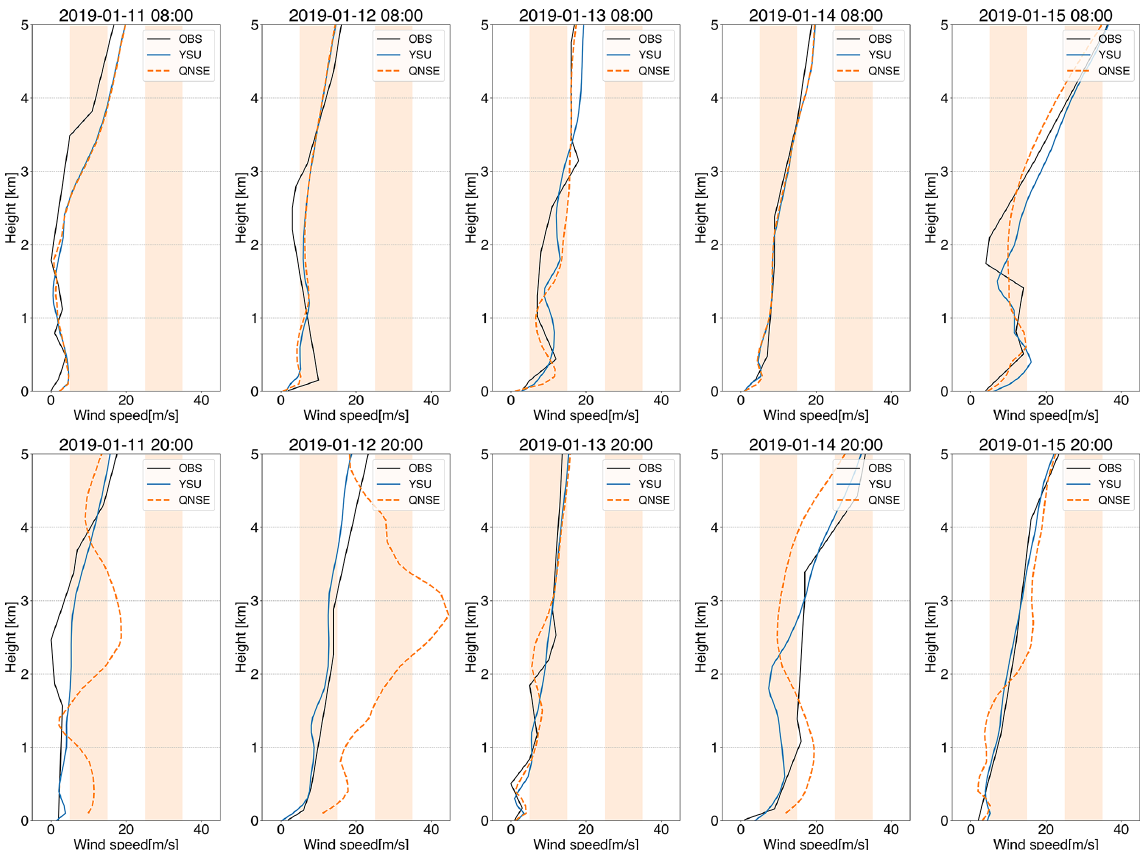
Figure 14. Wind speed profile from observations and simulations with the YSU and QNSE schemes at 08:00 and 20:00LT during the study period. Table 3. List of land surface models investigated in this study.